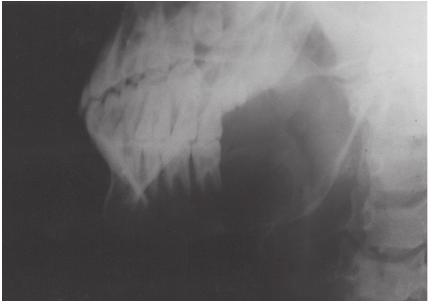
Figure 1: Clinical appearance of the swelling showing the di ff use borders.